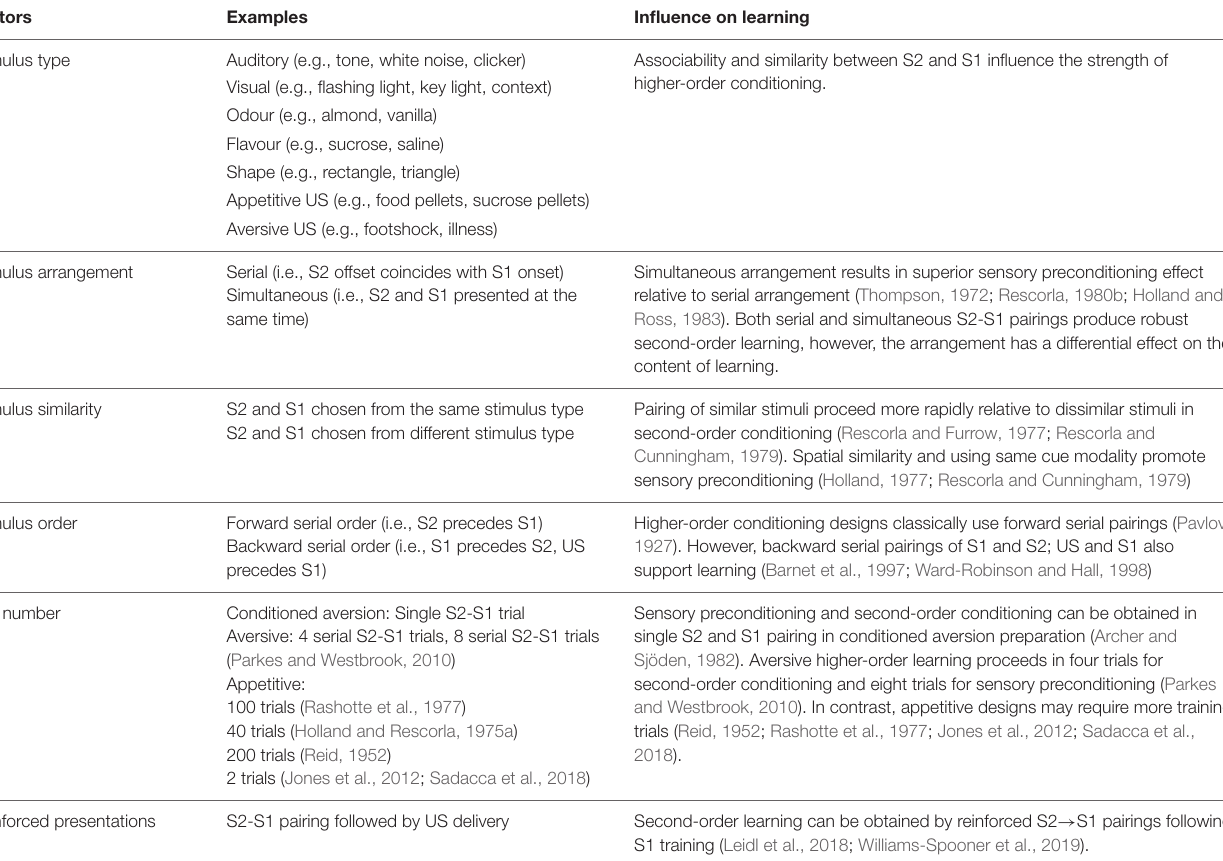
TABLE 1 | Procedures and factors that influence higher-order